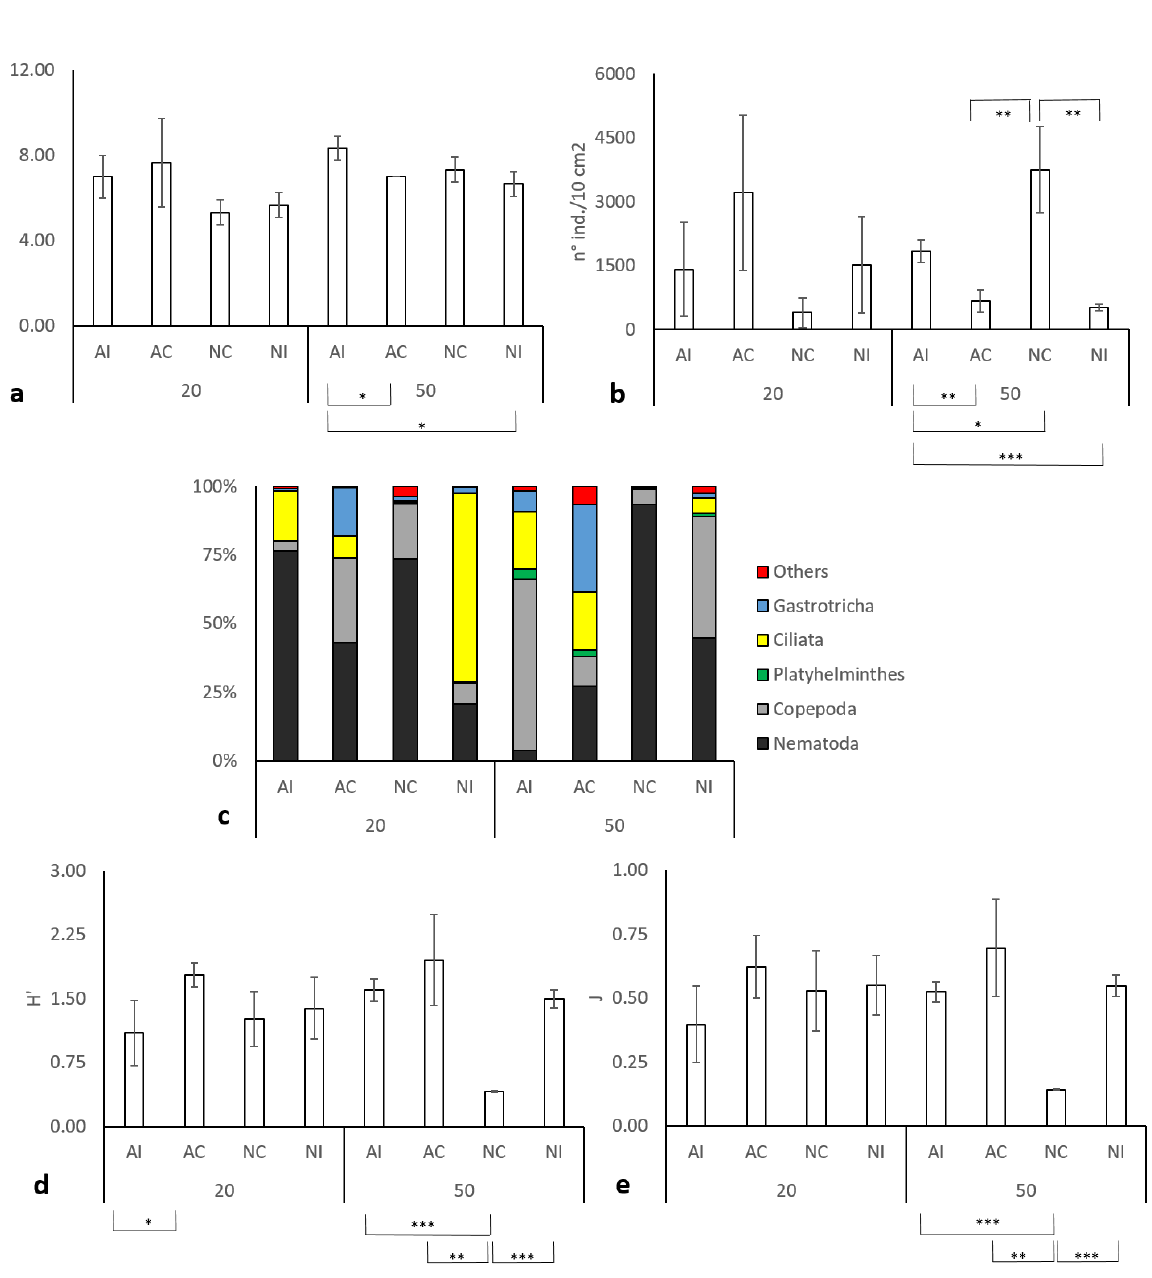
Figure 5. Trends of synecological indices and results of univariate analyses. ( a ) Number of meiobenthic taxa, ( b ) abundances, ( c ) percent composition of meiobenthic taxa (those taxa with less than 1% were grouped in the “Others” category), ( d ) diversity (H’) calculated as Shannon index, and ( e ) evenness (J) calculated as Pielou index. PERMANOVA significant differences among stations are also shown: * = p < 0.05, ** = p < 0.01, *** = p <